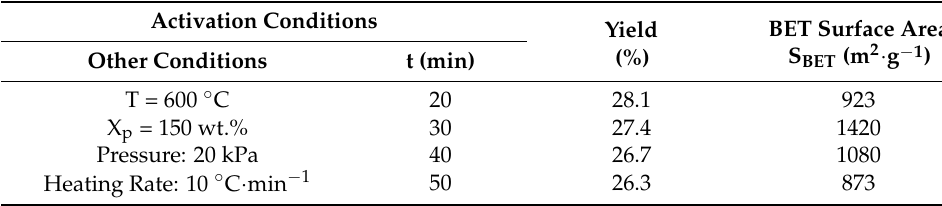
Table 3. Activation conditions, yield, and BET surface area of activated carbon.